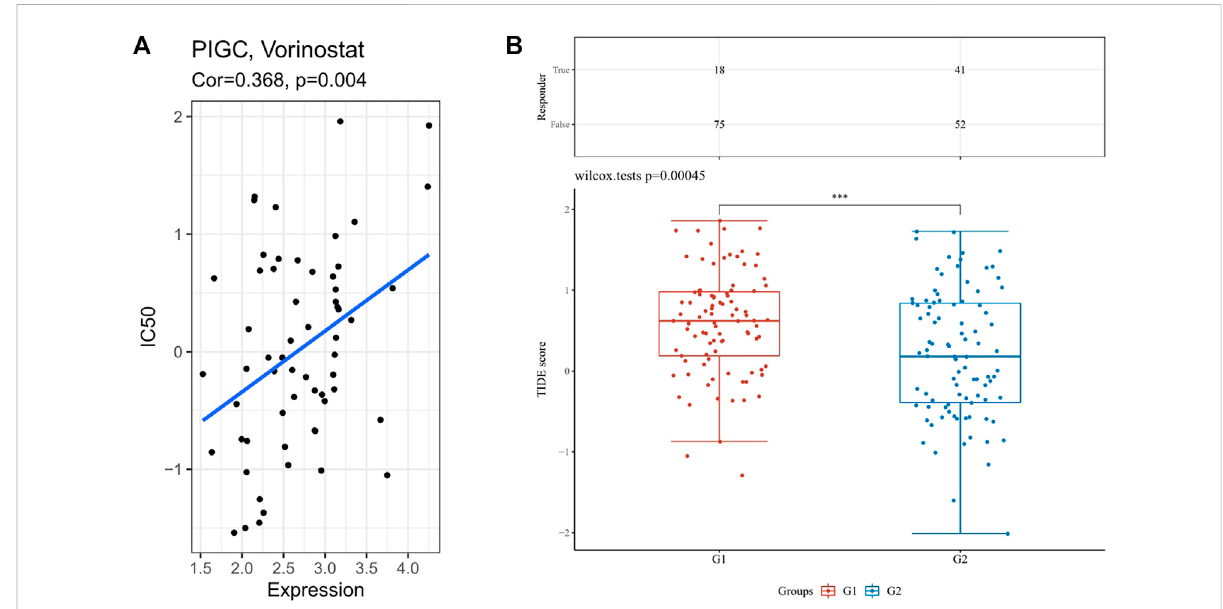
FIGURE 9 The analysis of drug sensitivity and immunotherapy response via R package (A) The correlation between the PIGC expression with the IC50. (B) TIDE score in different PIGC expression